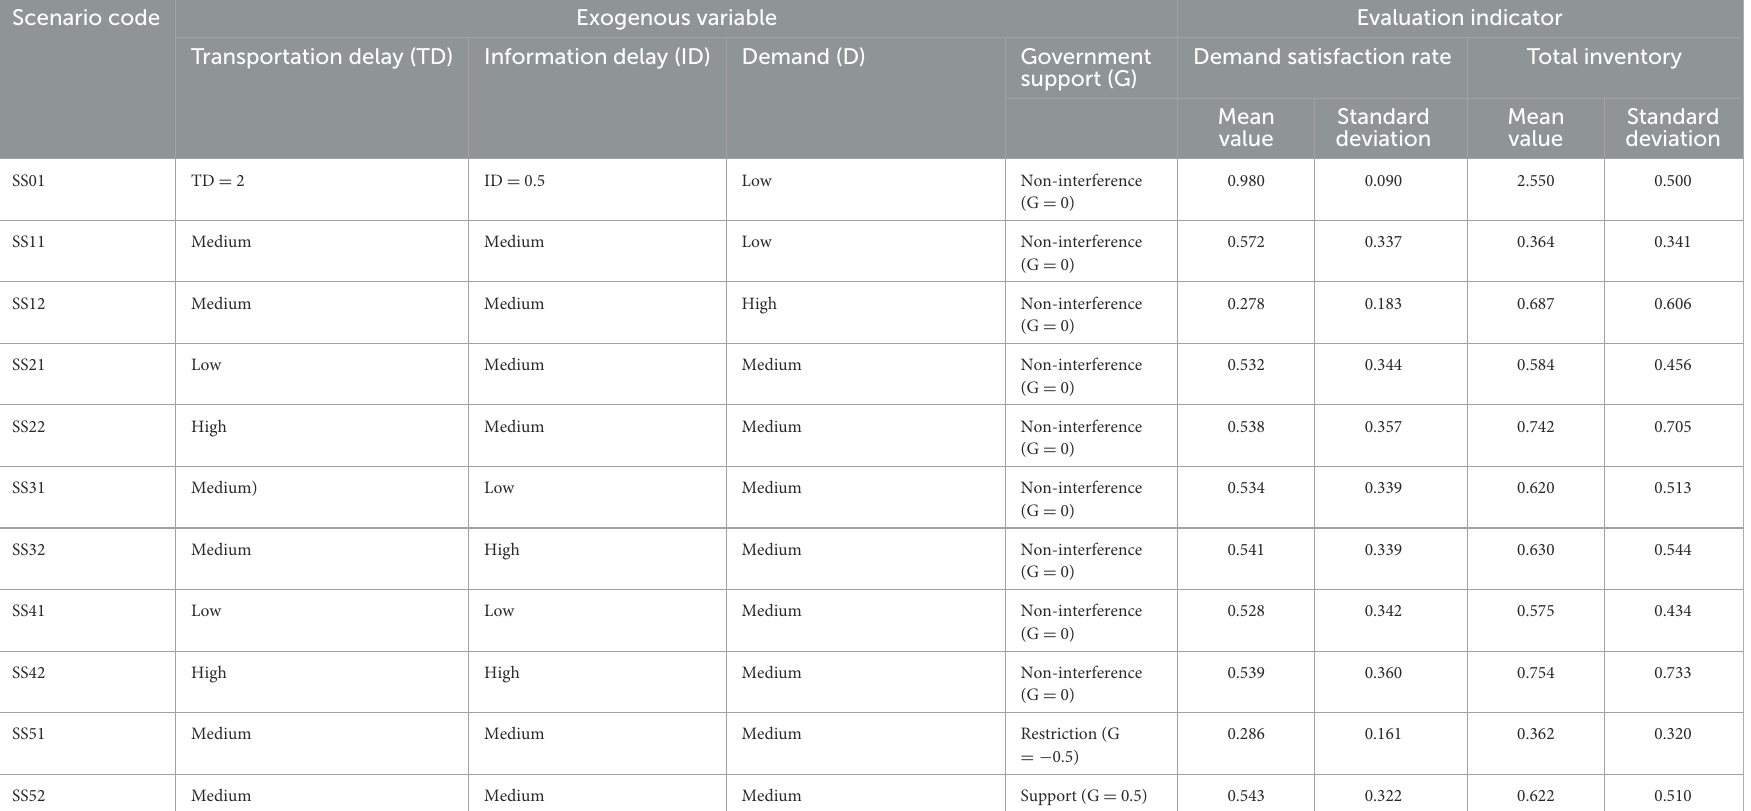
TABLE 3 Supply simulation